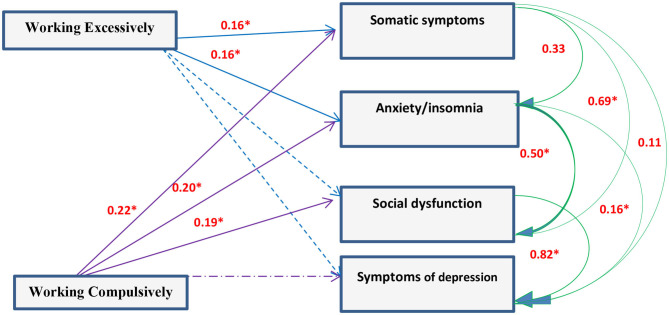
Path diagram of the model used for the whole group of subjects for work addiction scores and GHQ (n = 1,080) (Multiple regression analysis using pathway analysis was applied). *significant.